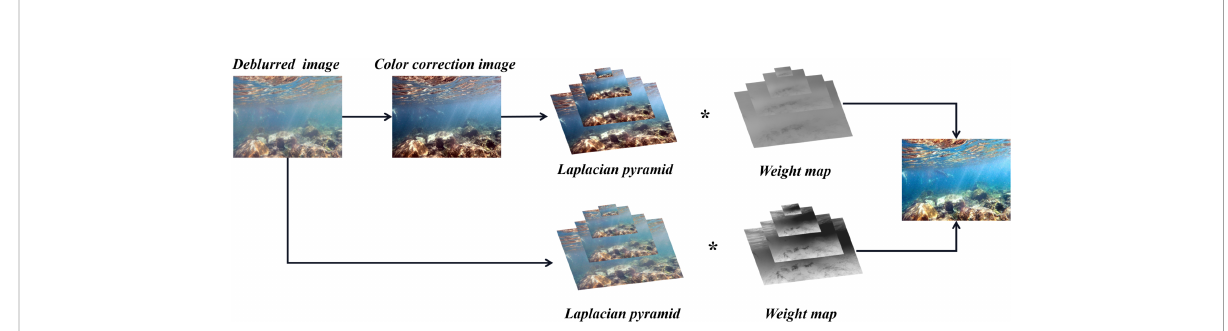
FIGURE 6 Flowchart of fusion processing. The output image is obtained by fusing the inputs with weight map at every pixel, where weight map is obtained by decomposing the input image into multi-scale of the Laplacian